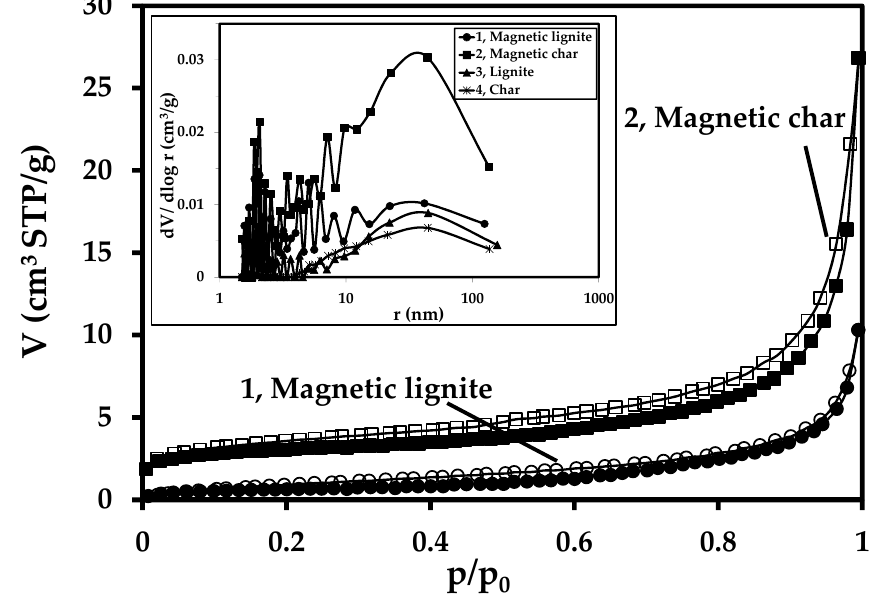
Figure 2. Nitrogen adsorption/desorption isotherm of magnetic lignite (1) and magnetic char (2). Solid datapoints in the isotherm correspond to the data from adsorption isotherm, and open datapoints correspond to the data from the desorption isotherm. Top left inset: pore-size distribution for magnetic lignite (1) and magnetic char (2) and their precursors, lignite (3) and char (4), derived from the desorption isotherms. STP, standard temperature and pressure (t = 0 °C and p = 101.325 kPa).